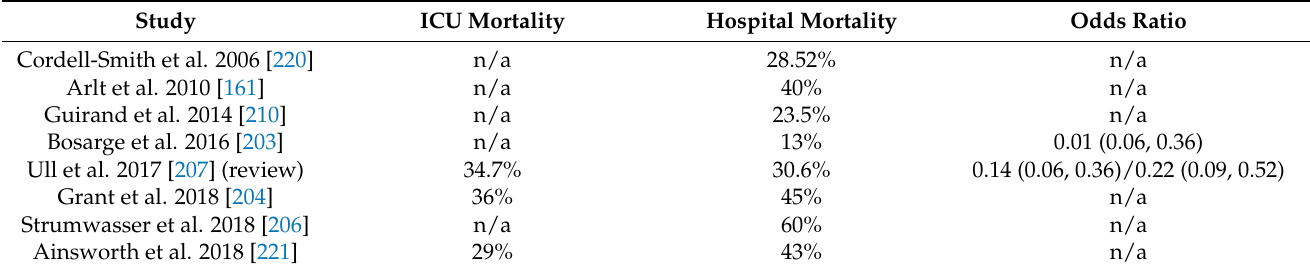
Table 9. Evidence for the use of vvECMO in trauma patients and the respective